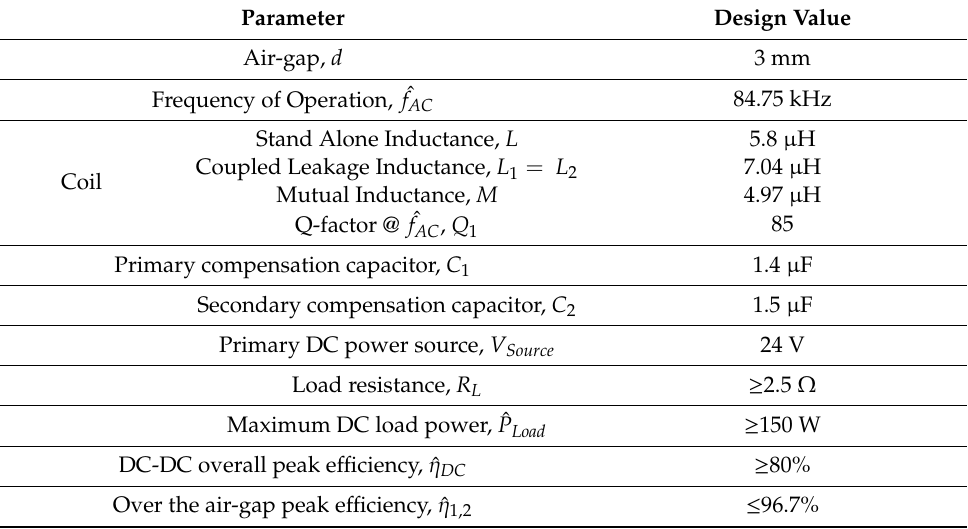
Table 2. Main WPT design